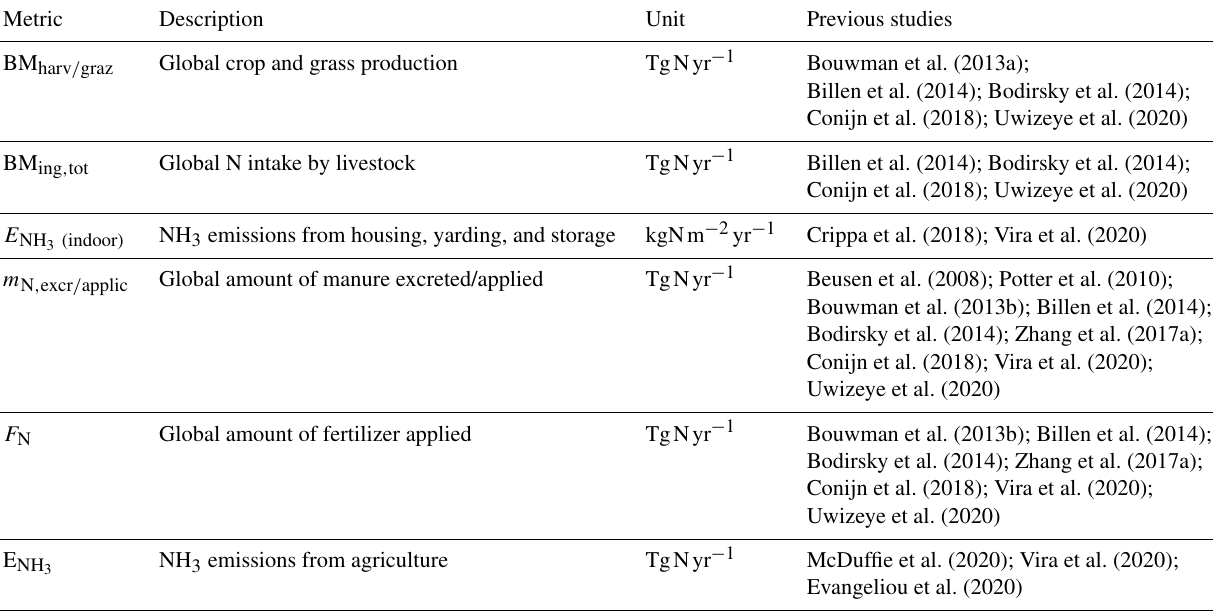
Table 6. Summary of the different simulated variables evaluated in this work by comparison with previous studies. Metric